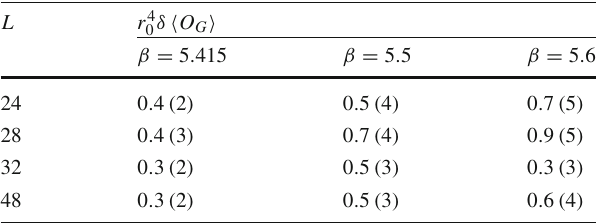
Table 7 Ambiguity of the gluon condensate determined from Eq. (64) at the three largest values of